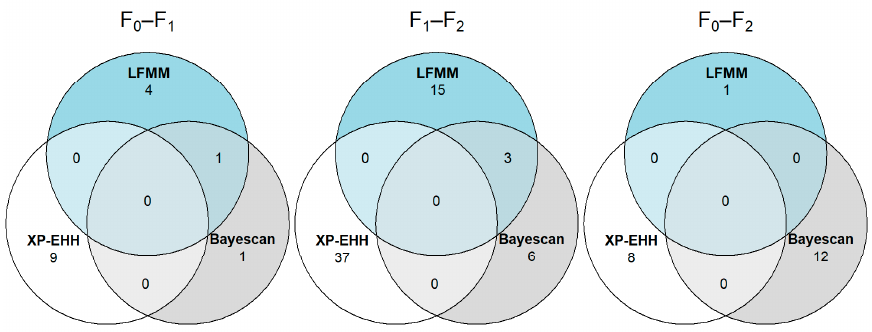
Figure 3. Venn diagrams showing overlapping loci considered significant between different methods for every pair of populations.